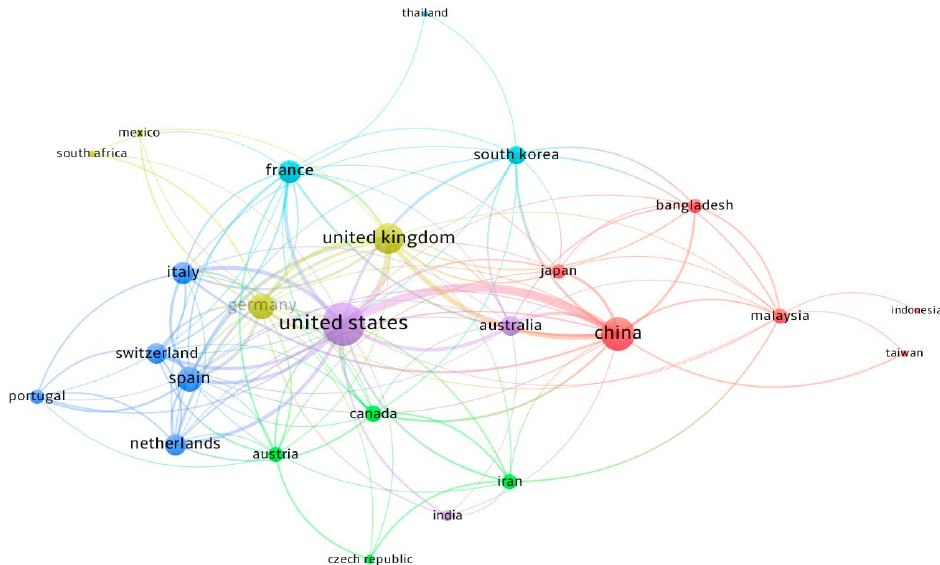
Figure 12. Network visualization map of country co-authorships in the DR field. Countries with a minimum of 10 published and cited articles were included. The map includes 25 out of 90 countries in 6 clusters. Total link strength of the top 5 countries are as follows: USA = 100, China = 65, United Kingdom = 55, Germany = 40, Spain = 37.